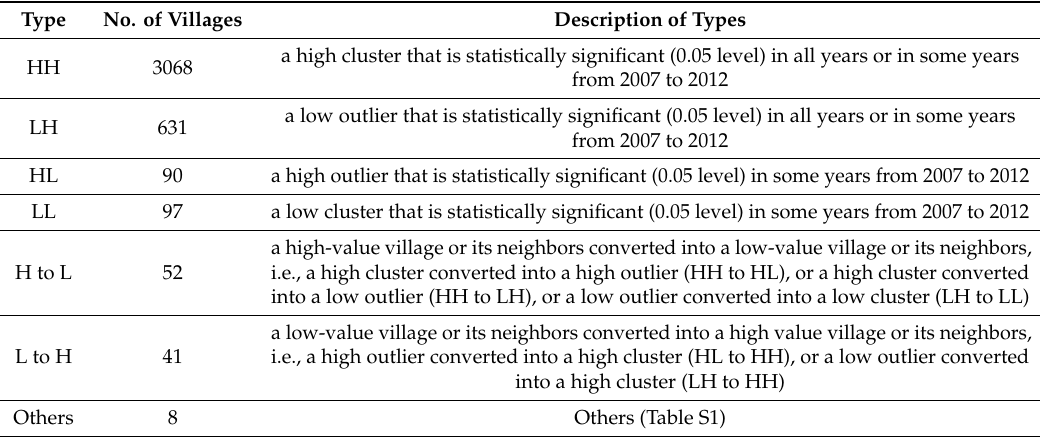
Figure 2. Cluster and outlier evolution for schistosomiasis RIR (resident infection rate) from 2007 to 2012 in the 30 most endemic counties, Hubei Province. Table 1. Combined cluster / outlier found by the local Moran’s I analysis for schistosomiasis RIR (resident infection rate).